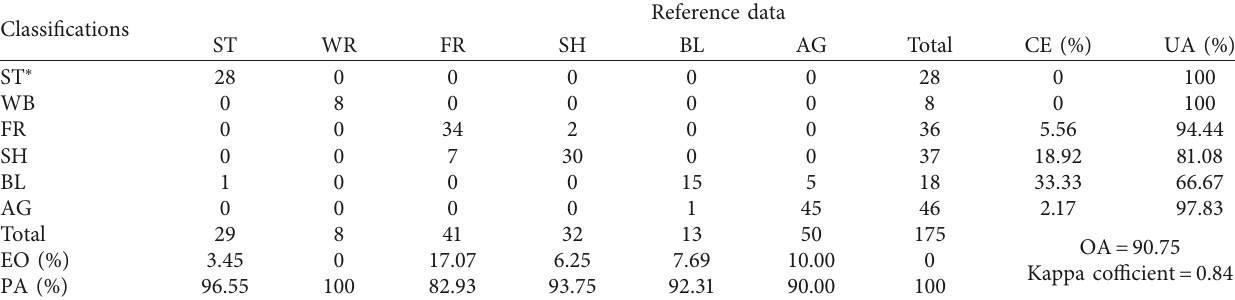
Table 4: Confusion matrix accuracy for the classification of 2010.